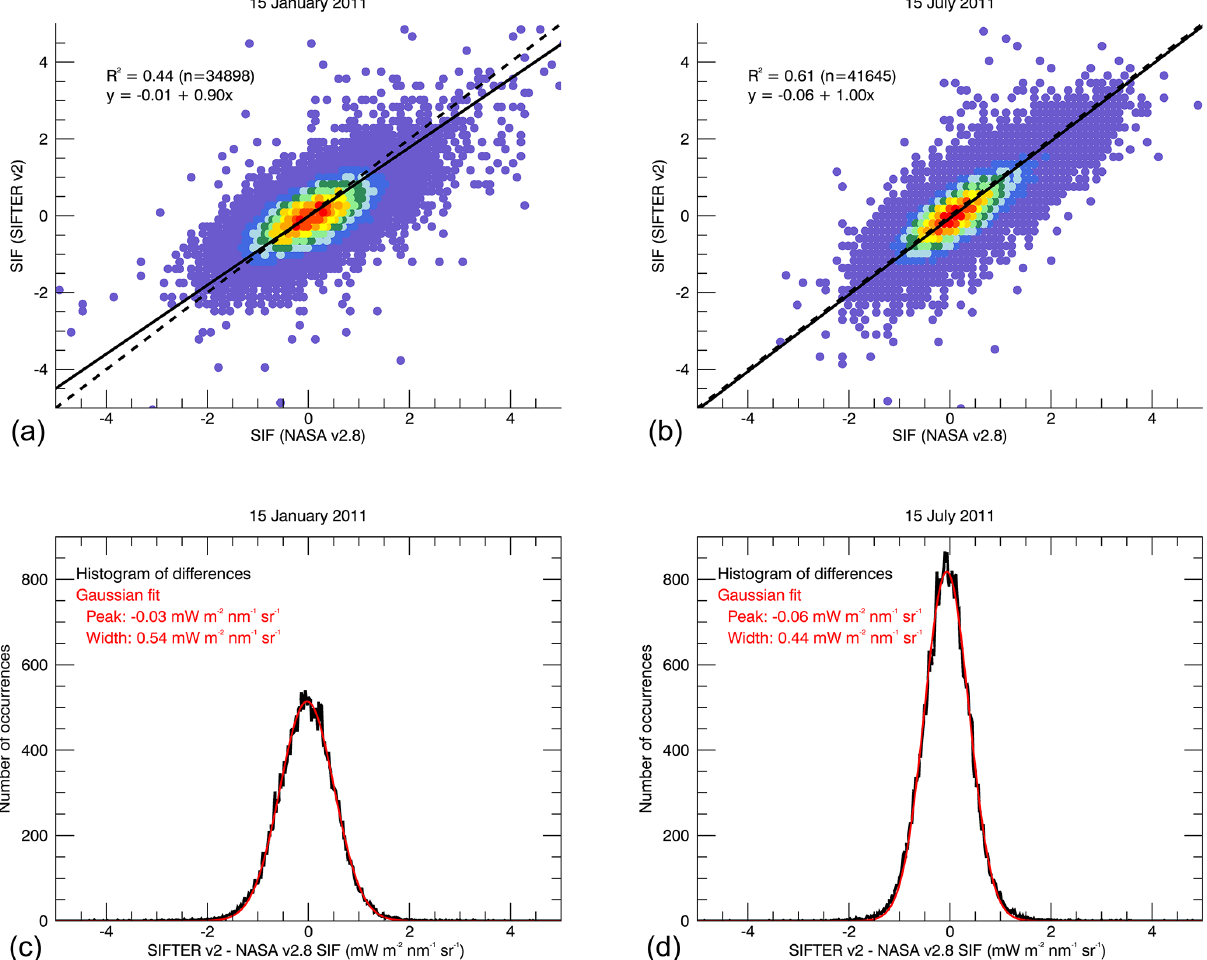
Figure 8. Scatterplots of SIFTER v2 vs. NASA v2.8 GOME-2A fluorescence retrievals (in mWm − 2 nm − 1 sr − 1 ) on 15 January and 15 July 2011. Only co-located pixels over land (albedo > 0.08) with (NASA) cloud fraction < 0.3 have been selected, and pixels were required to be valid in both retrievals. The colours indicate the density of occurrence of combinations of fluorescence values. The legend in (a, b) gives the result of a reduced major axis regression between the fluorescence